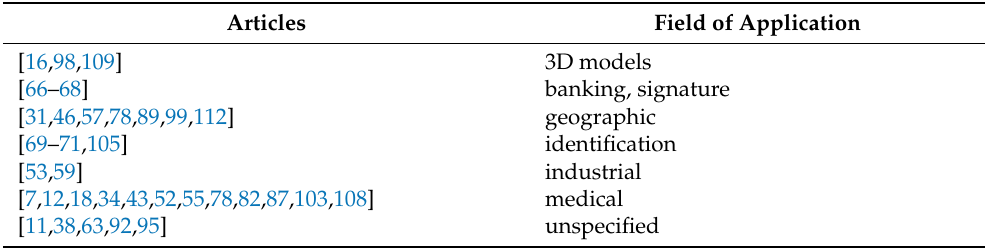
Table 1. Fields of application in the reviewed